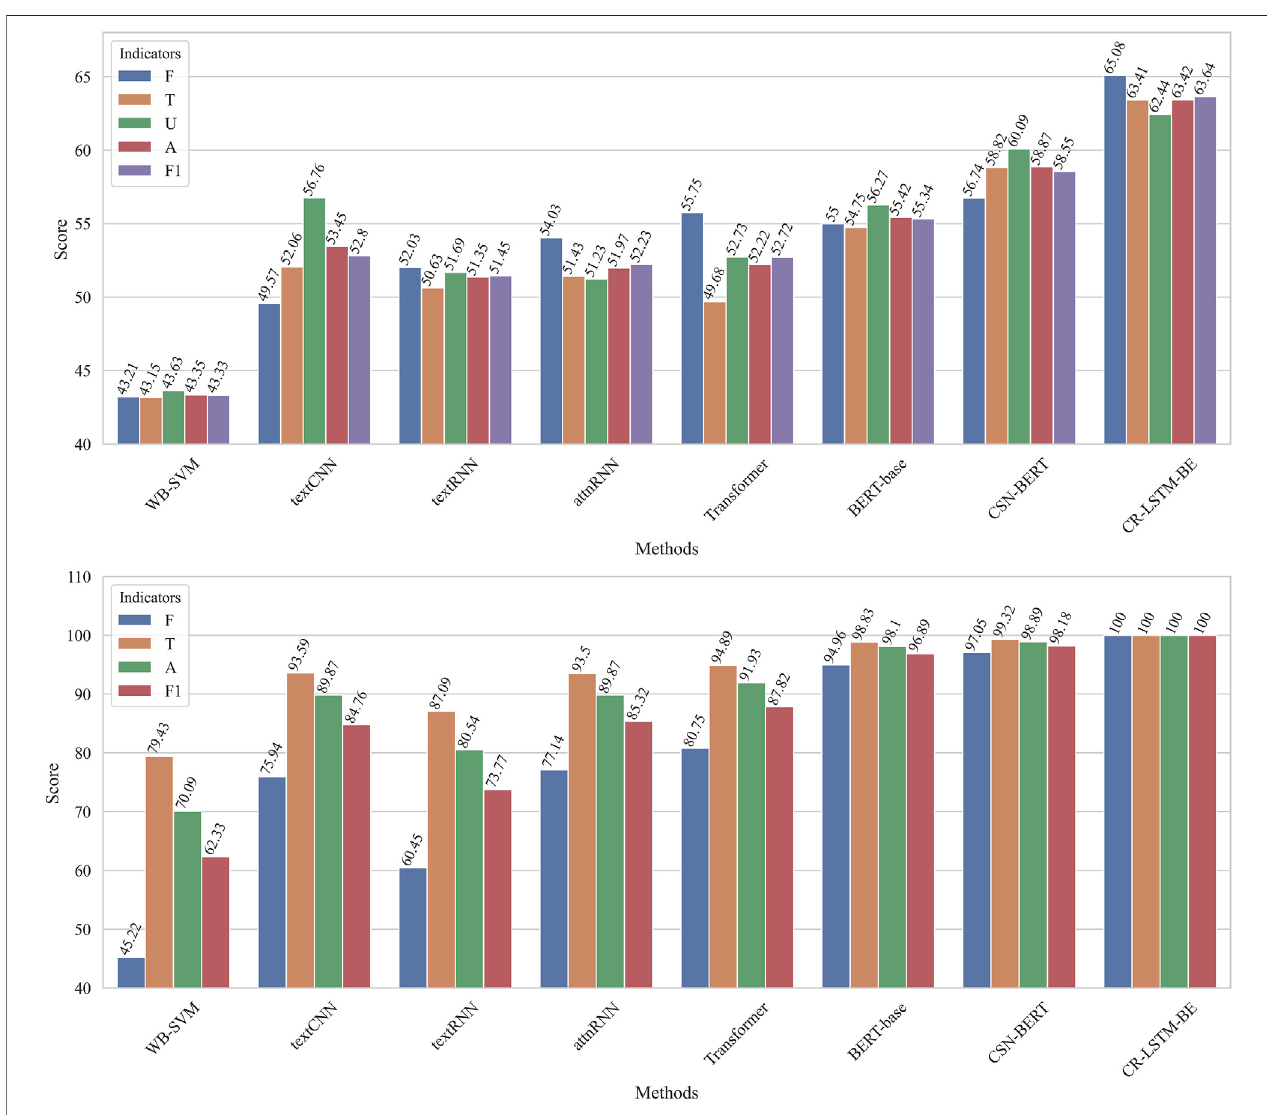
FIGURE 4 | The performance of methods on different rumor labels (F: False, T: True, U: Unveri fi ed, A: Accuracy, F1: Macro F1).